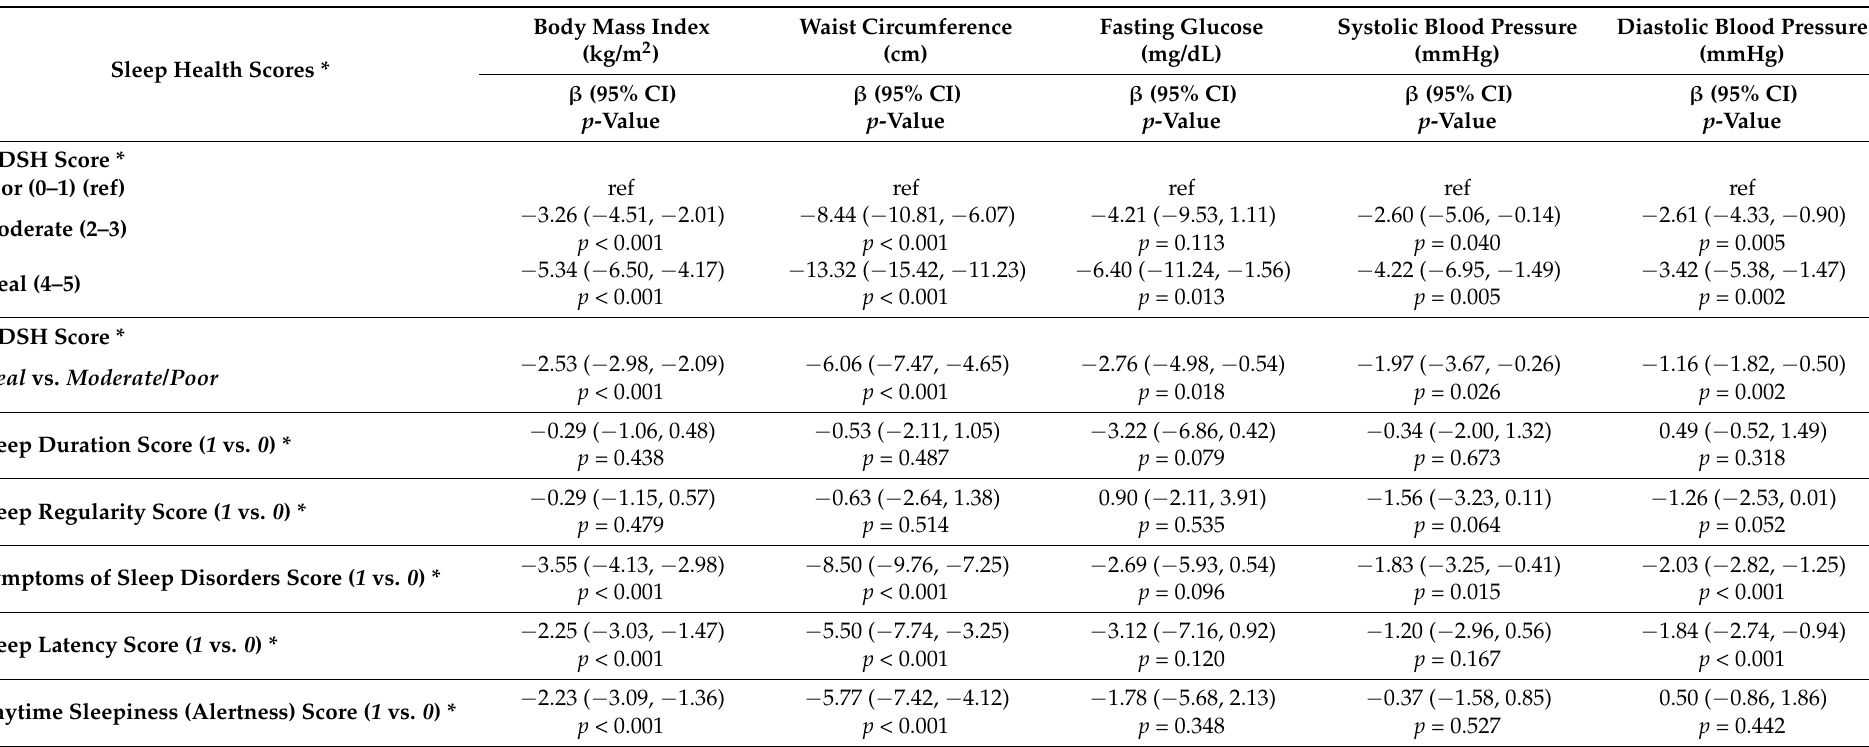
Table 2. Multivariable-Adjusted Linear Regression Models for Associations of Multidimensional Sleep Health with Body Mass Index, Waist Circumference, Fasting Glucose, and Blood Pressure (n = 4555) †